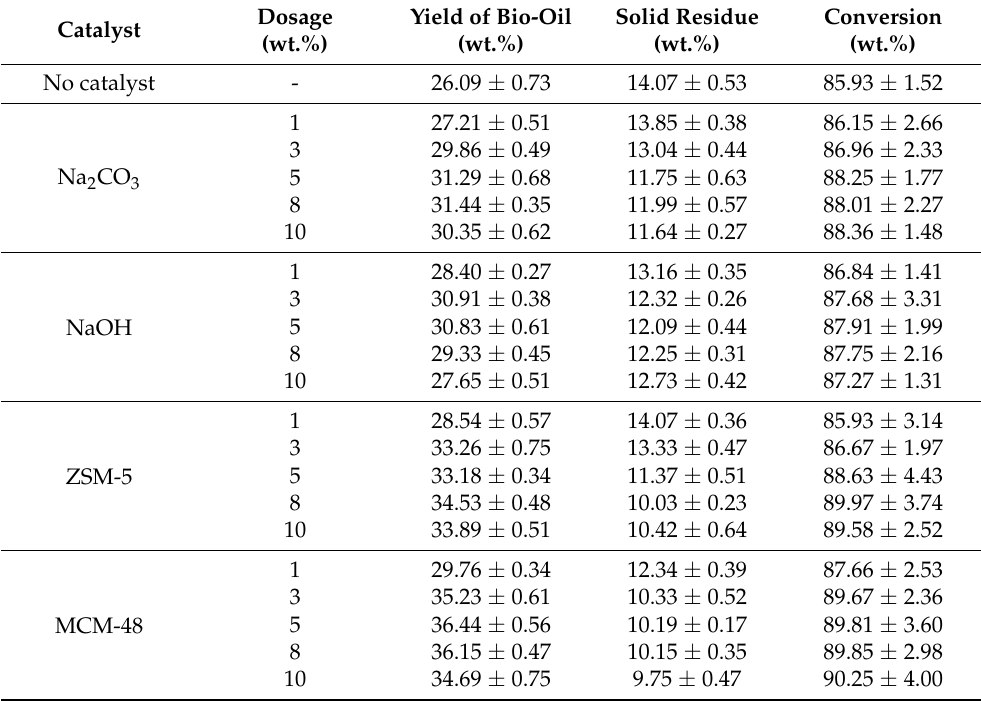
Table 1. Influence of the catalyst dosage on the distribution of hydrothermal liquefaction products. Dosage Yield of Bio-Oil Solid Residue Conversion Catalyst (wt.%) (wt.%) (wt.%) (wt.%) No catalyst - 26.09 ±